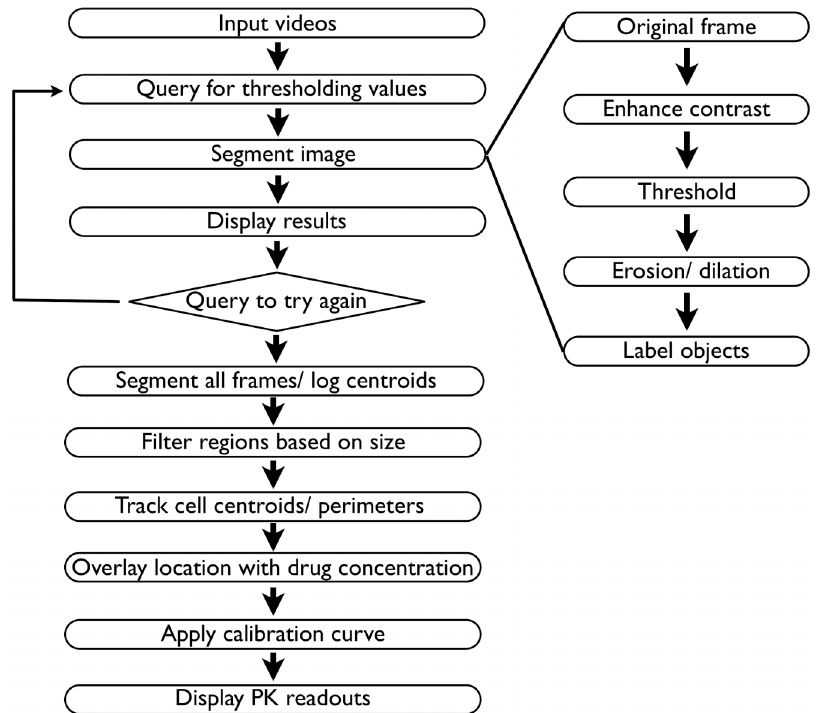
Figure 3. Overview of the image processing method. The left side of the diagram displays the overall proposed algorithm for analyzing intravital images and determining drug concentration. This algorithm is made up of an iterative section that allows the user to generate the best possible segmentation (top) and a processing module that filters through all videos after satisfactory values have been obtained. On the right, the specific segmentation algorithm used in conjunction with the thresholding method is displayed.